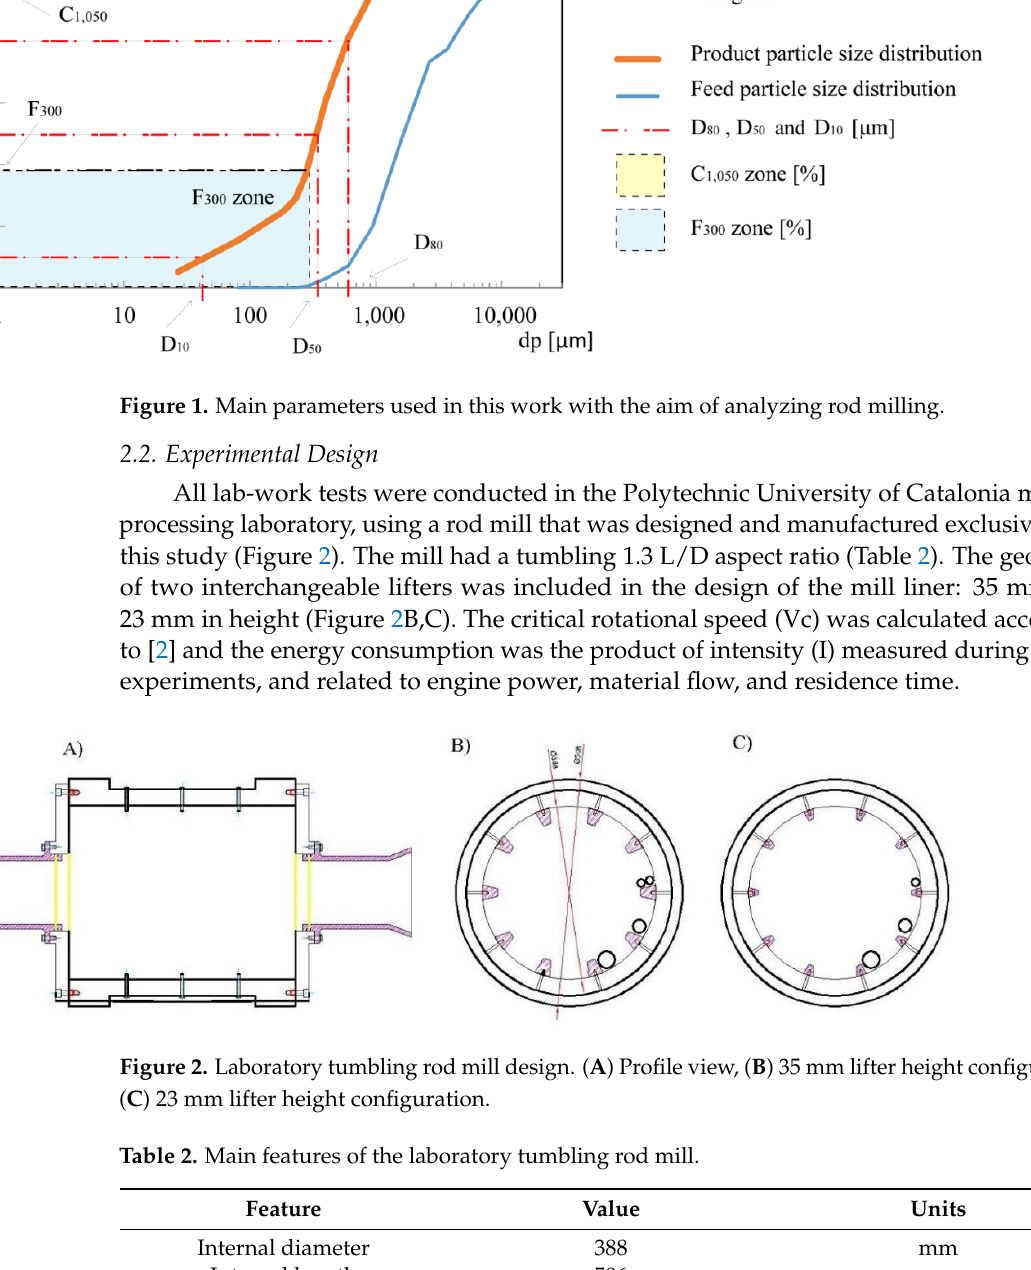
Figure 1. Main parameters used in this work with the aim of analyzing rod milling .